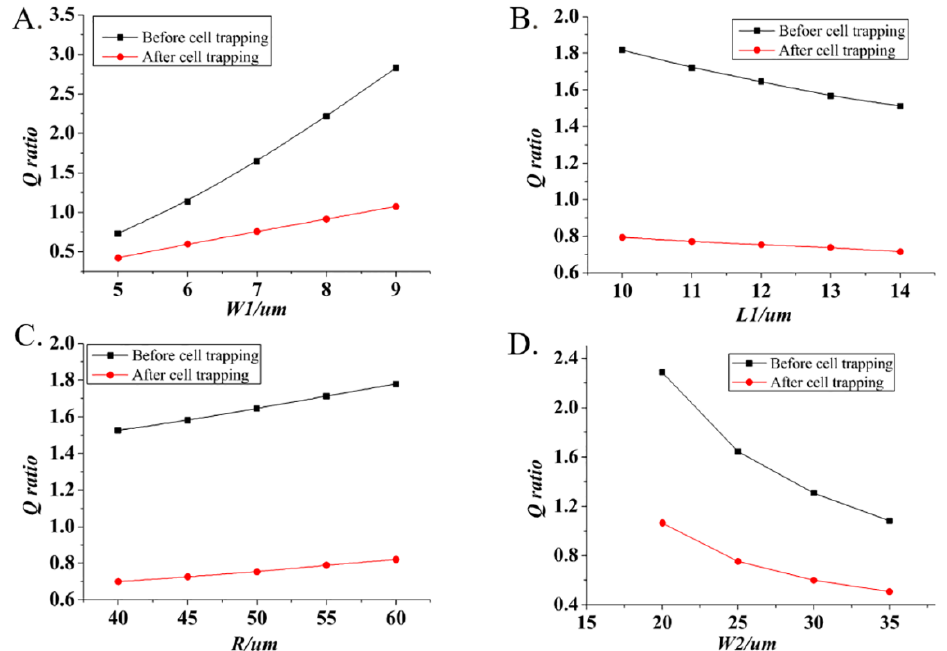
Figure 3. The effects of chip geometric parameters on the Q ratio values before and after cell trapping. ( A ) The Q ratio increased as W 1 increased before and after cell trapping. ( B ) The increase of L 1 led to the decrease of Q ratio before and after cell trapping. ( C ) The Q ratio increased with the increase of as R before and after cell trapping. ( D ) The increase of W 2 caused the decrease of Q ratio before and after cell